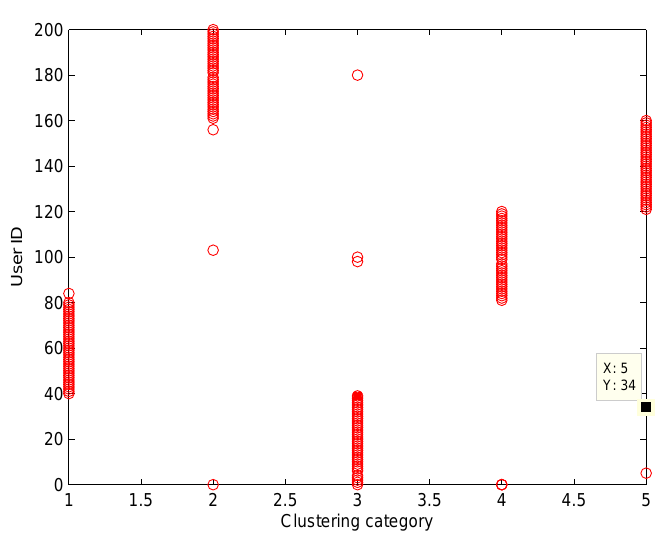
Figure 7. Result of SFCM cluster based on threshold.